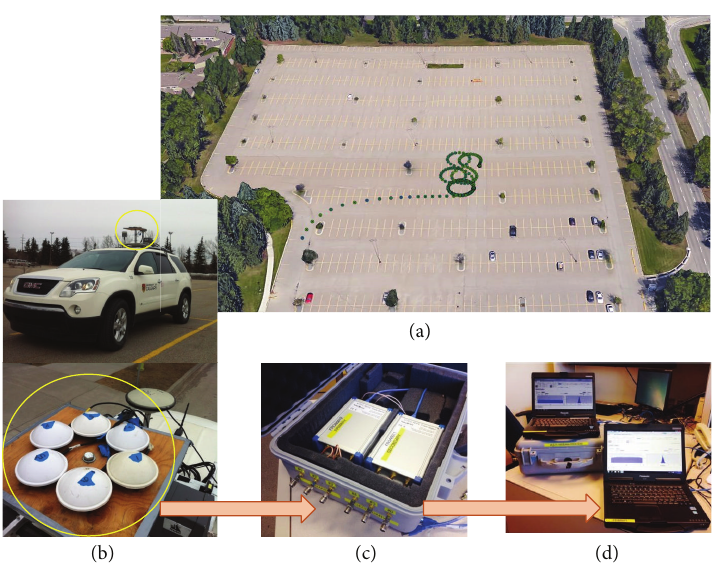
Figure 9: Data collection scenario and